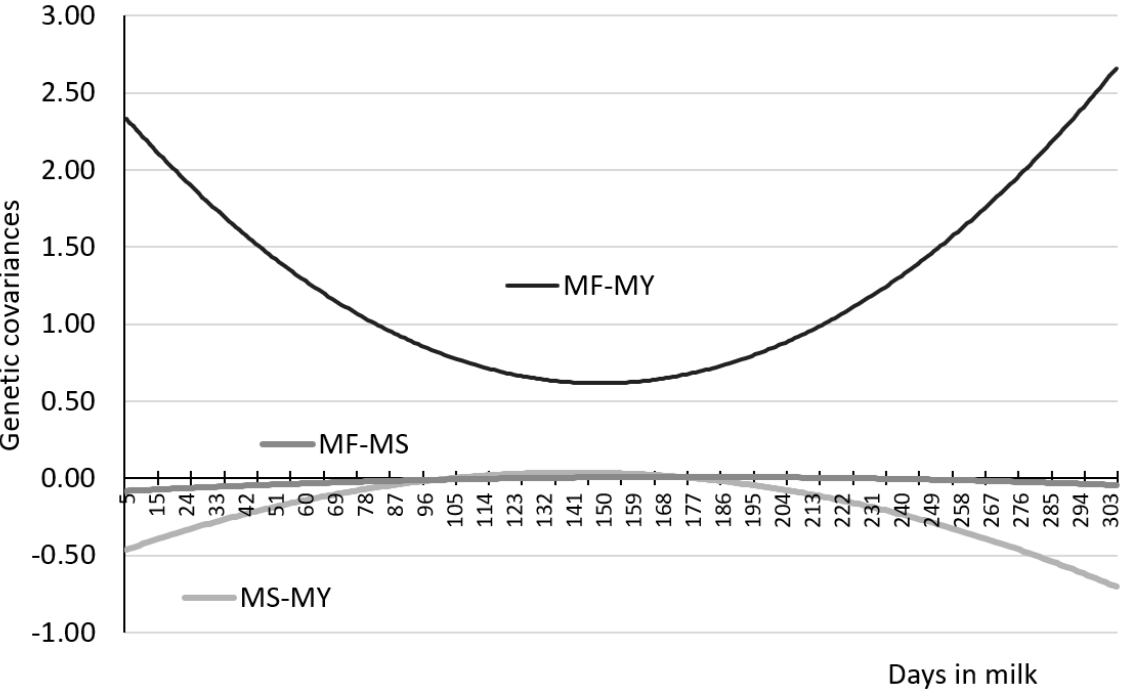
Figure 4. Genetic covariances for controlled pairs of traits primiparous cows, where MS-MY—milking speed and milk yield covariance, MF-MY—milking frequency and milk yield covariance, MF-MS—milking frequency and milking speed covariance.